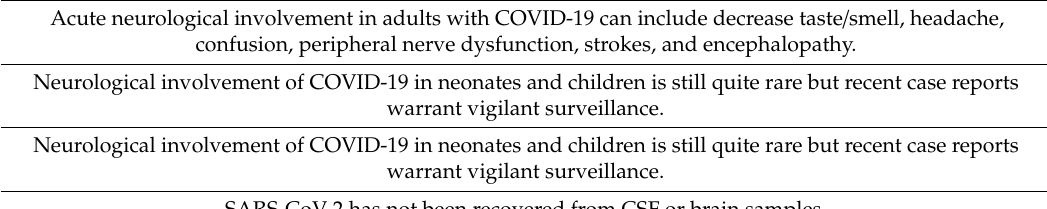
Table 5. Neurological involvement in